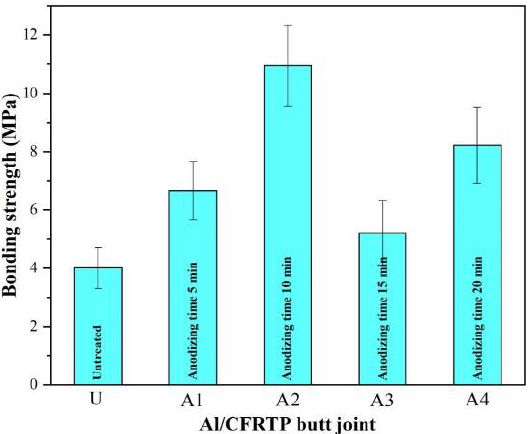
Figure 9. Variation of the bonding strength of the Al/CFRTP butt join with different anodizing pretreated Al interface.